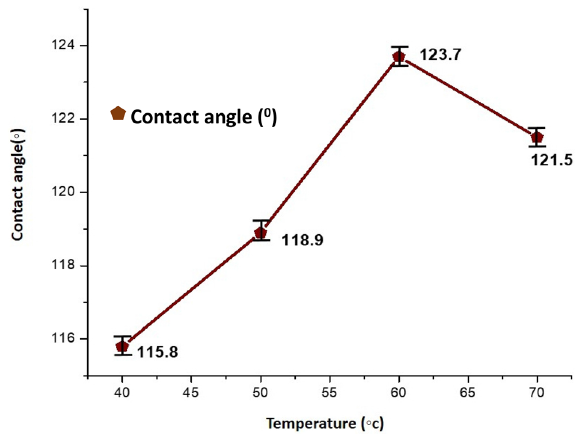
Fig. 9 A graphical demonstration of the influence of the tempera- ture on contact angle